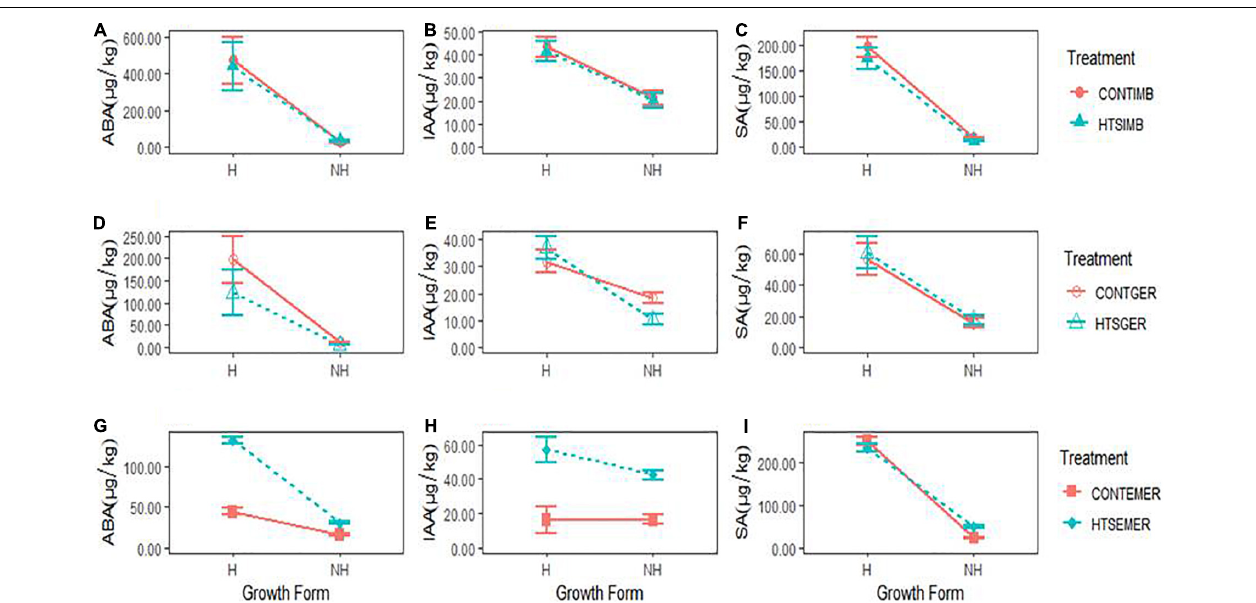
FIGURE 3 | The concentrations of three endogenous phytohormones, abscisic acid (ABA), indole-3-acetic acid (IAA), and salicylic acid (SA), in two growth forms (H = hemiepiphytic and NH = non-hemiepiphytic) of Ficus species when high temperature stress (HTS) was applied at different regeneration stages: seed imbibition (HTSIMB), seed germination (HTSGER), and seedling emergence (HTSEMER). The HTS was applied as 40 ◦ C for 8h from 10:00 am to 6:00 pm, and the respective control treatment (CONT) was not given an HTS treatment. (A–C) The concentration of ABA, IAA, and SA after HTSIMB and for their control treatments graphs. (D–F) The concentration of ABA, IAA, and SA after HTSGER and for their control treatments. (G–I) The concentration of ABA, IAA, and SA after HTSEMER and for their control